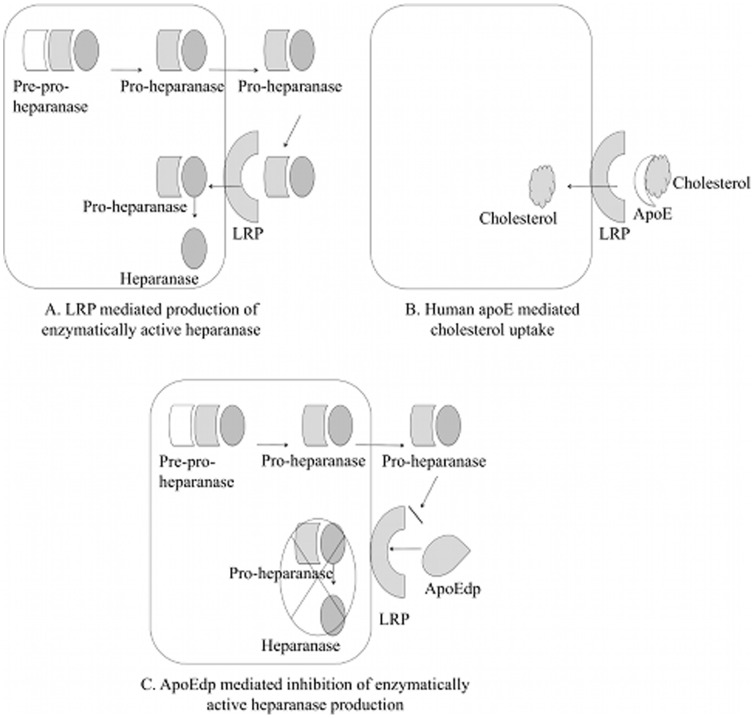
Possible mechanisms of apoEdp mediated heparanase inhibition.(A). Heparanase is produced as a larger precursor protein (pro-heparanase). LRP-1 on ECs known to rapidly bind the secreted pro-heparanase and transfer the internalized pro-heparanase to late endosomes/lysosomes. Pro-heparanase is proteolytically cleaved into enzymatically active form in intracellular lysosomal/endosomal compartments and remains localized. (B). Human apoE protein binds to the same receptor LRP present on the cell surface ECM. (C) The apoEdp competitively inhibits hREC uptake and internalization through LRP-1 arresting the production of active heparanase.